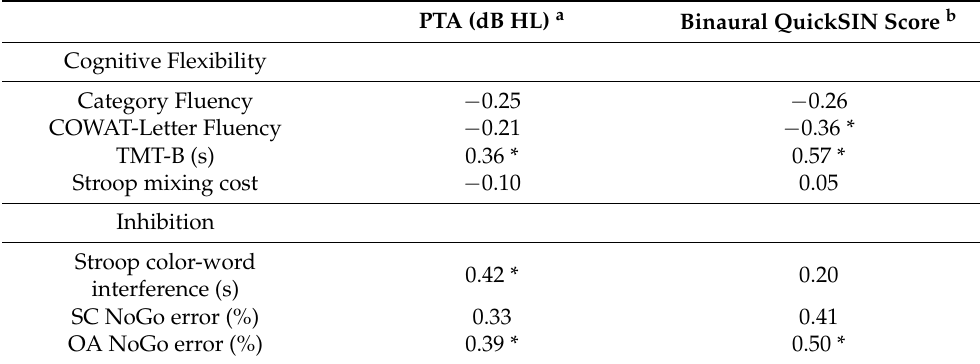
Table 4. Correlations between Hearing and Cognitive Control